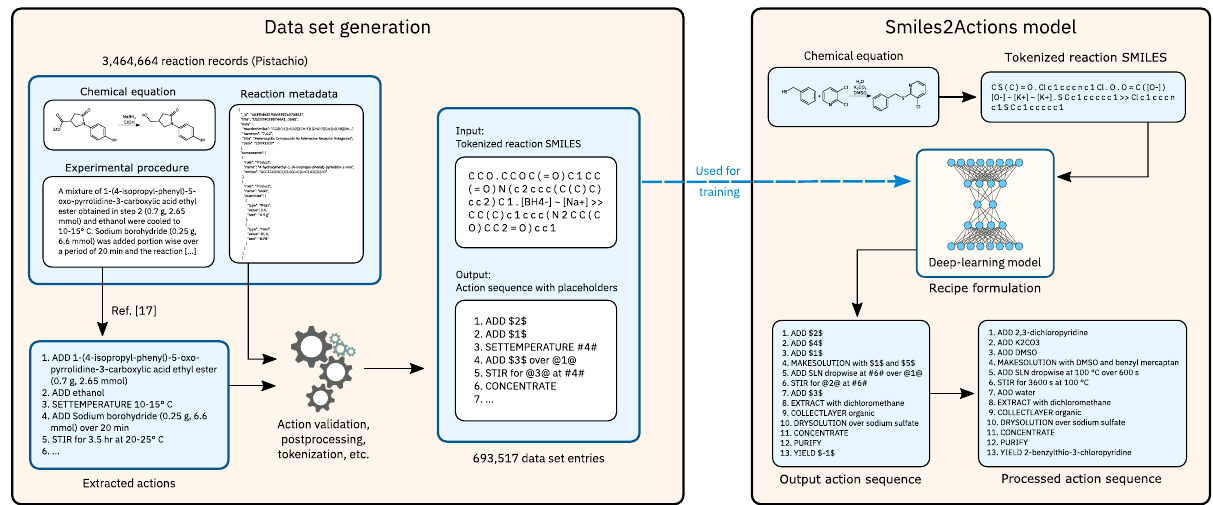
Fig. 1 Overview of the data set generation and Smiles2Actions model. The data set is generated in a sequence of processing and fi ltering steps, starting from information available in patent reaction records (on the left). The Smiles2Actions model is trained on this data set, after which it can predict the action sequences to execute arbitrary chemical equations (on the